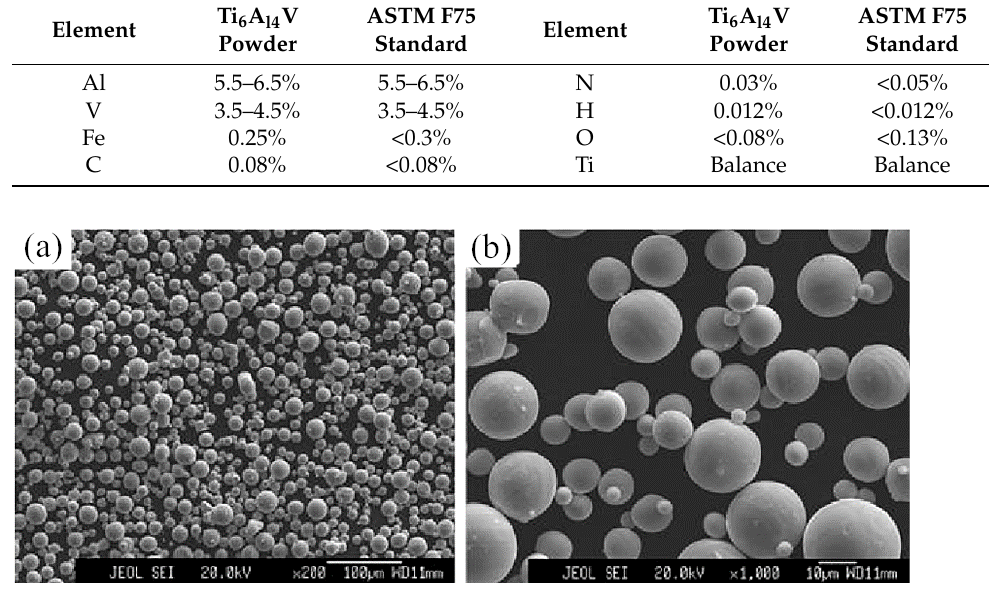
Figure 1. Microstructure of Ti 6 A l4 V alloy powder: ( a ) 100× microstructure; ( b ) 1000× microstructure.